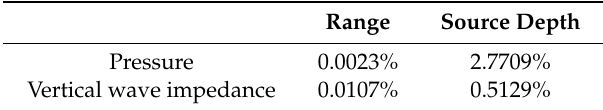
Figure 6. Localization results for the measured vector as the pressure (black line) and the vertical wave impedance (red line). ( a ) Range estimation result with pressure as the measured vector; ( b ) source depth estimation result with pressure as the measured vector; ( c ) range estimation result with vertical wave impedance as the measured vector; ( d ) source depth estimation result with vertical wave impedance as the measured vector. Table 5. Mean absolute percentage error (MAPE) of localization results in the frequency domain of 25 Hz–100 Hz.